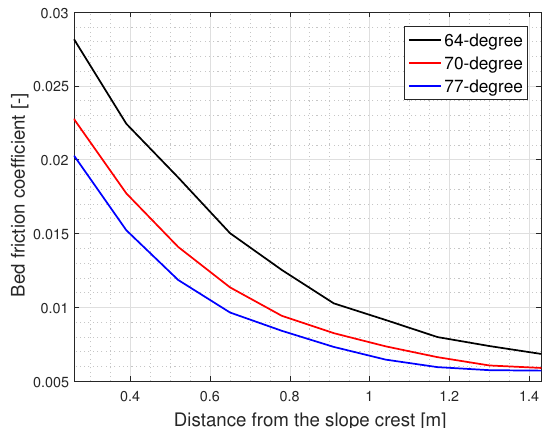
Figure 15. Spatial change of bed friction coefficient along the breach face.